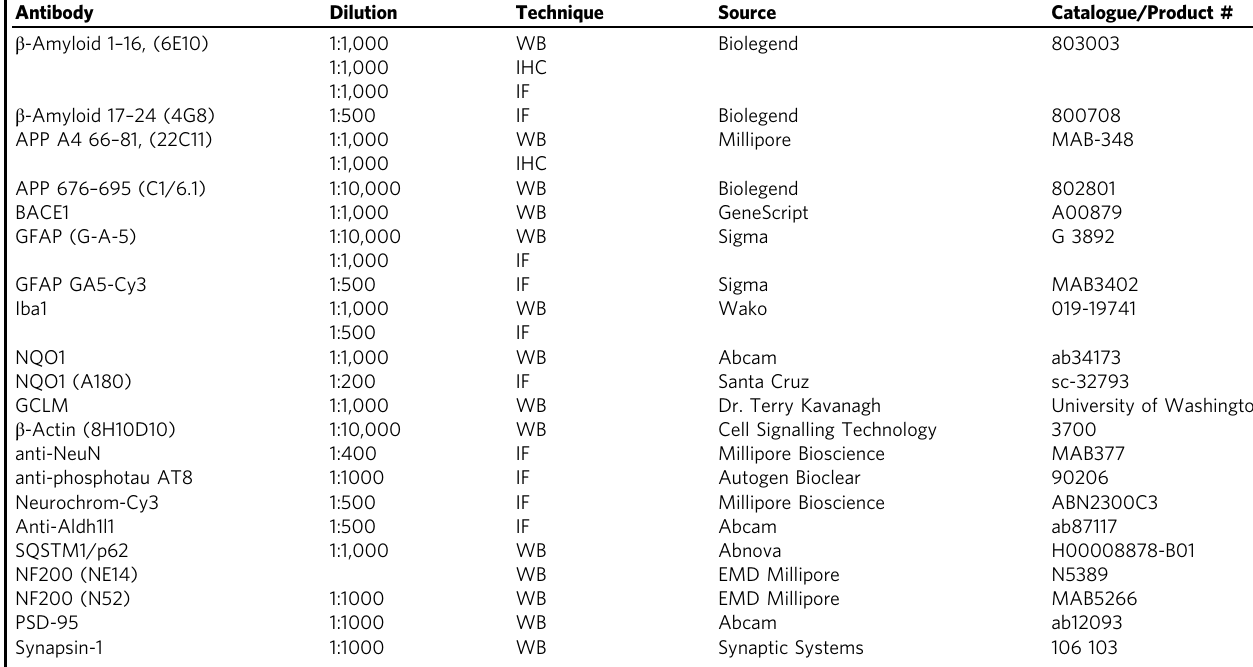
Table 2 Antibodies